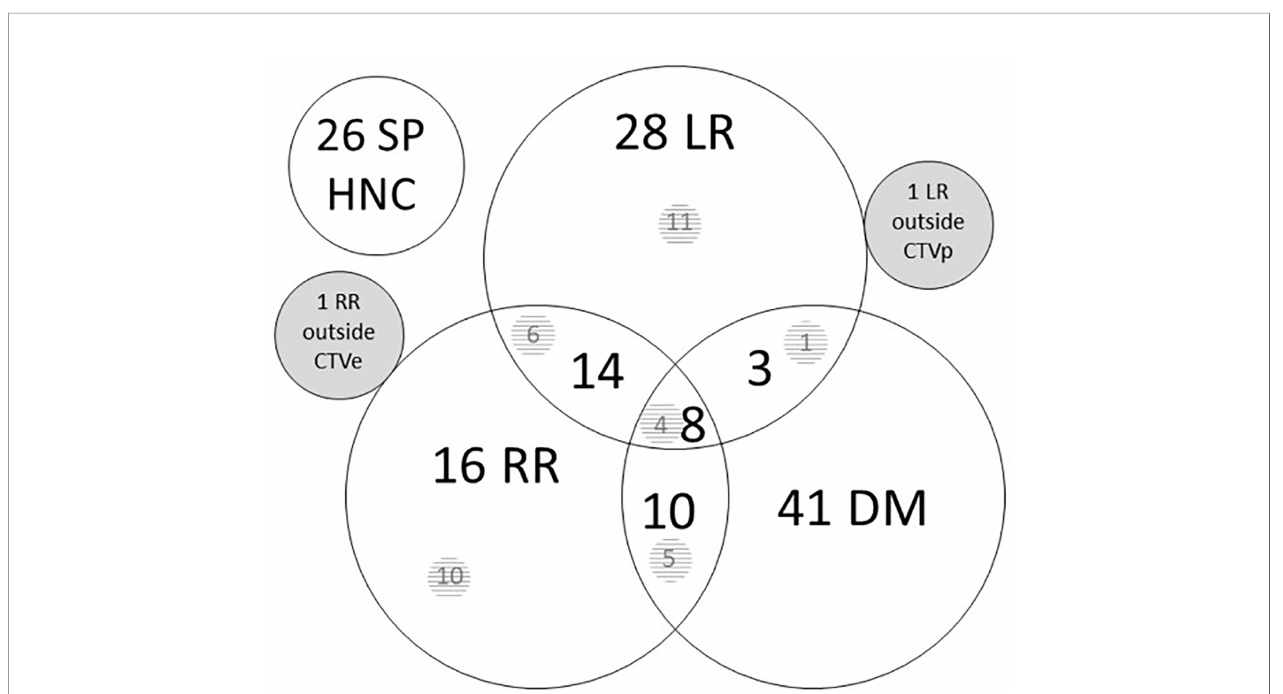
FIGURE 1 | Site of fi rst recurrence. Number of patients with a recurrence in the different sites. Overlapping circles show combination possibilities. There were one isolated local recurrence outside CTVp and one isolated regional recurrence outside CTVe. The numbers in the shaded area represent persistent tumors after the end of treatment, included in the total number of recurrences, e.g., 10 of 16 RR were persistent after treatment. CTVe, elective clinical target volume; DM, distant metastases; HNC, head and neck cancer; LR, local recurrence; RR, regional recurrence; SP, second